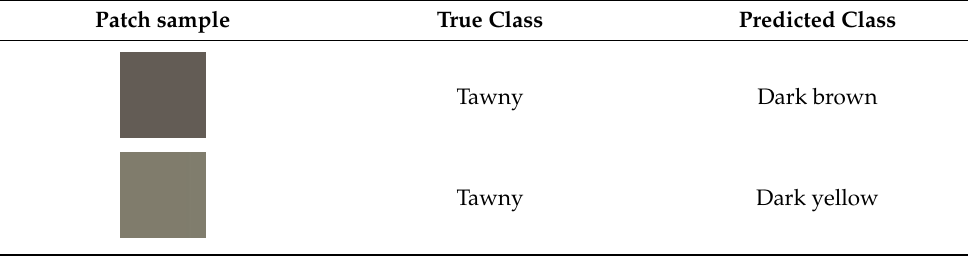
Table 9. Misclassified cases for class 12: tawny color.